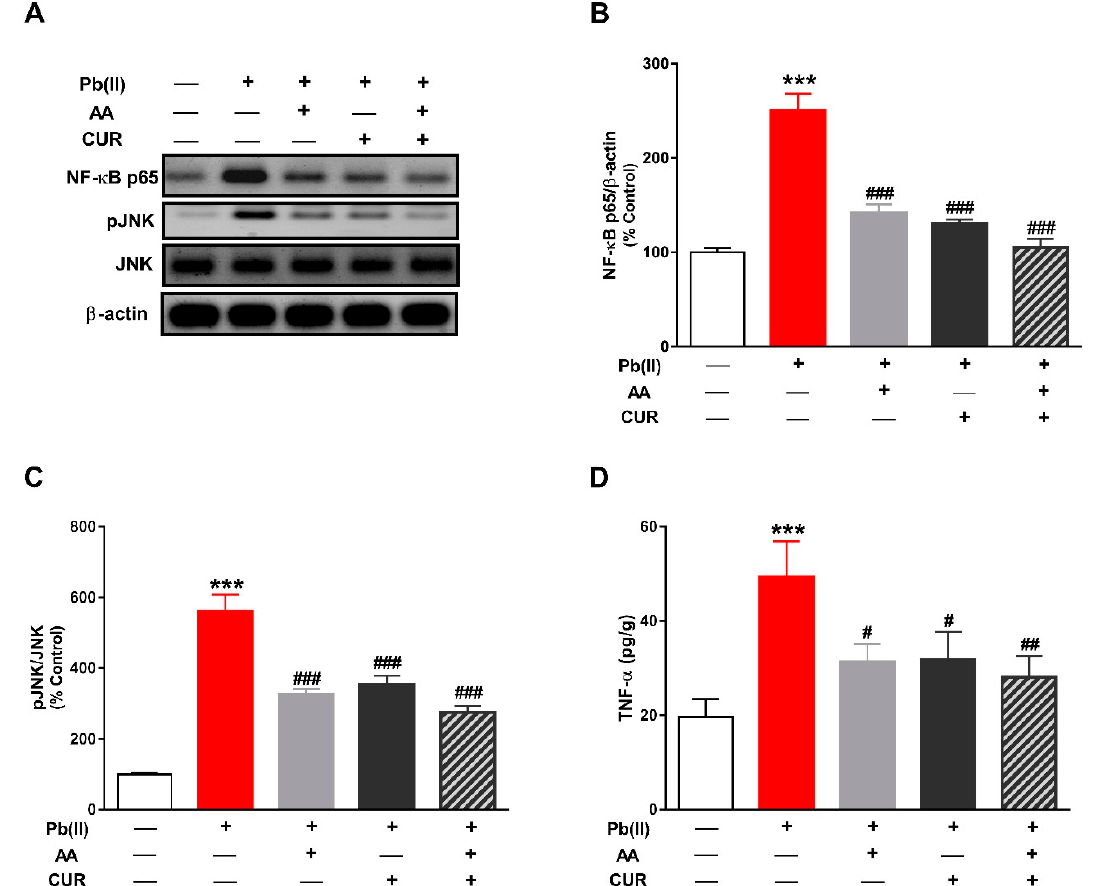
Figure 5. CUR inhibits inflammation in Pb(II)-induced rats. ( A ) Representative blots of NF- κ B p65, pJNK, JNK and β -actin. ( B – D ) CUR, AA and their combination decreased the phosphorylation levels of NF- κ B ( B ) and JNK ( C ), and TNF- α levels ( D ) in liver of Pb(II)-intoxicated rats. Data are expressed as Mean ± SEM, ( n = 6). *** p < 0.001 versus Control. # p < 0.05, ## p < 0.01 and ### p < 0.001 versus Pb(II).